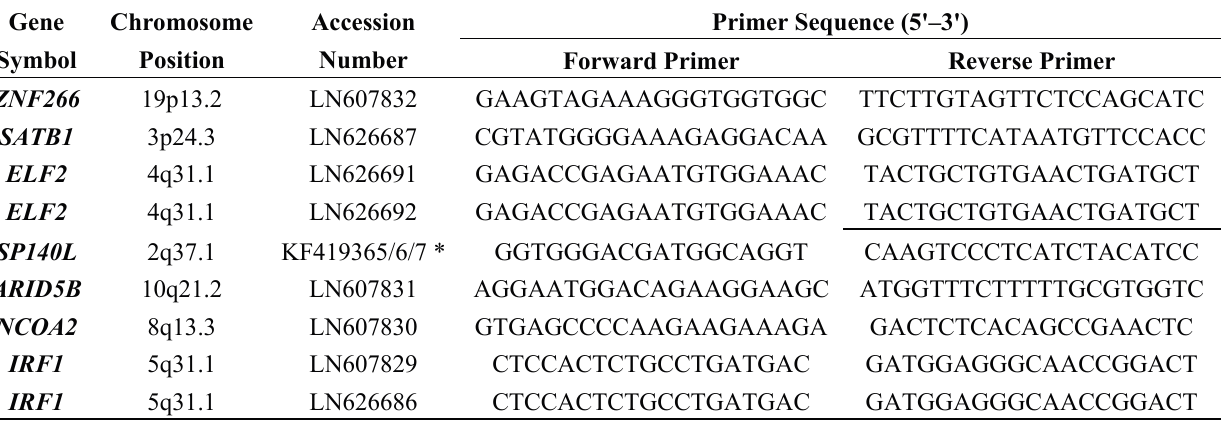
Table 1. Novel identified TFs transcripts with accession numbers and primer pairs used for RT-PCR